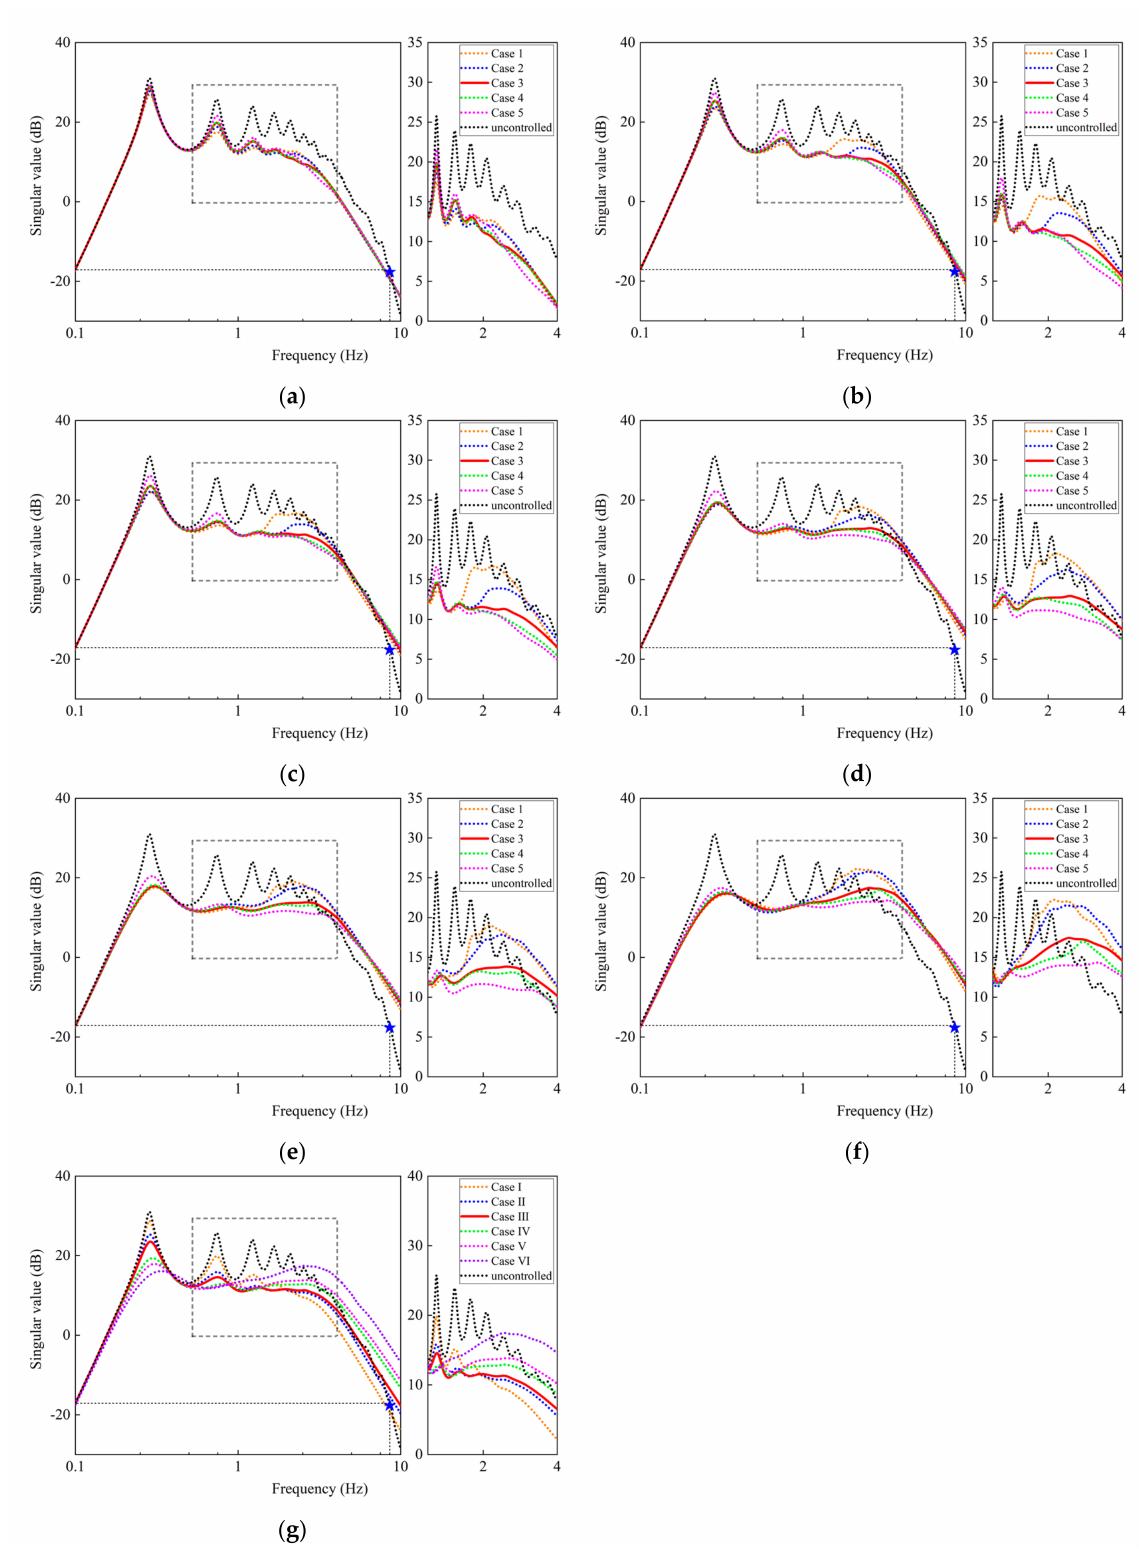
Figure 4. Comparison of singular-value Bode indexes of closed-loop system transfer function of under different weight coefficients: ( a ) Case I; ( b ) Case II; ( c ) Case III; ( d ) Case IV; ( e ) Case V; ( f ) Case VI; ( g ) Case I–IV in the Case